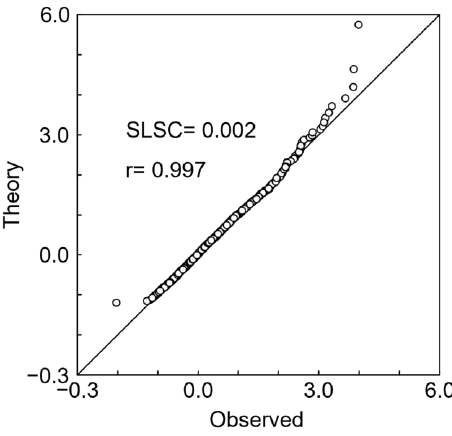
Figure 5. Boxplots for normalized values of annual maximum daily rainfall at 23 stations. Whiskers of the box show 25th (lower) and 75th (upper) percentile values. The gray line is the median value.